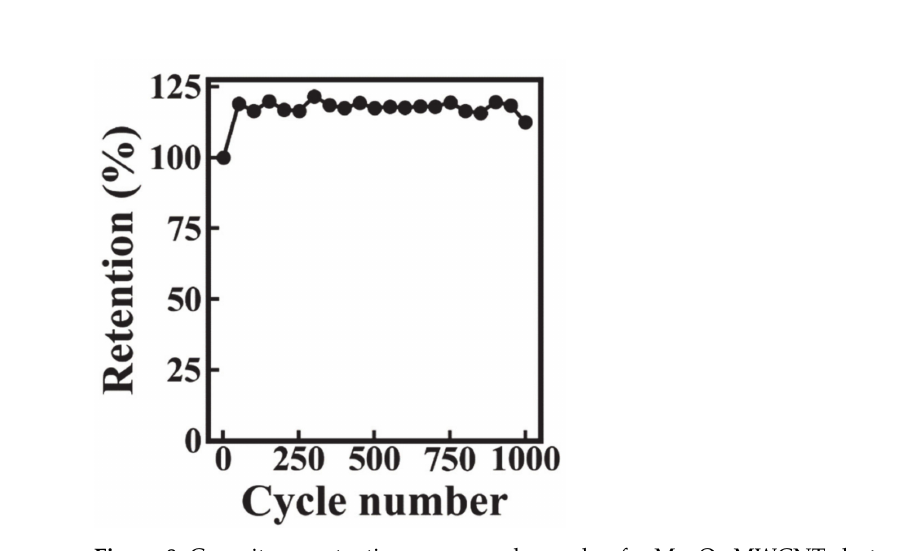
Figure 8. Capacitance retention versus cycle number for Mn 3 O 4 -MWCNT electrodes.